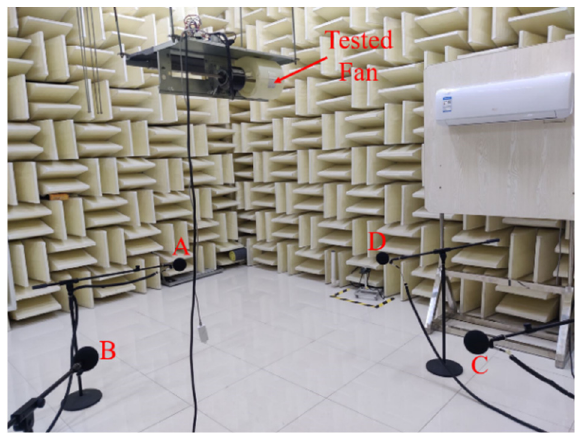
Figure 5. Acoustic measuring system and microphone A–D.